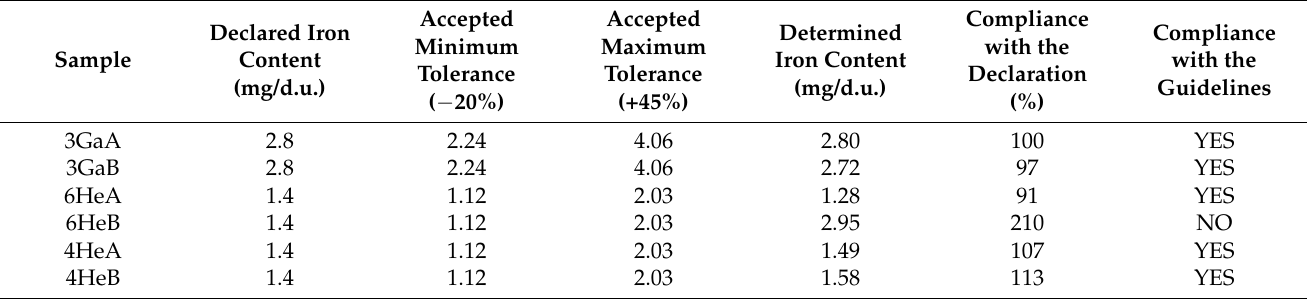
Table 6. Compliance of the determined iron content with manufacturers’ declarations and